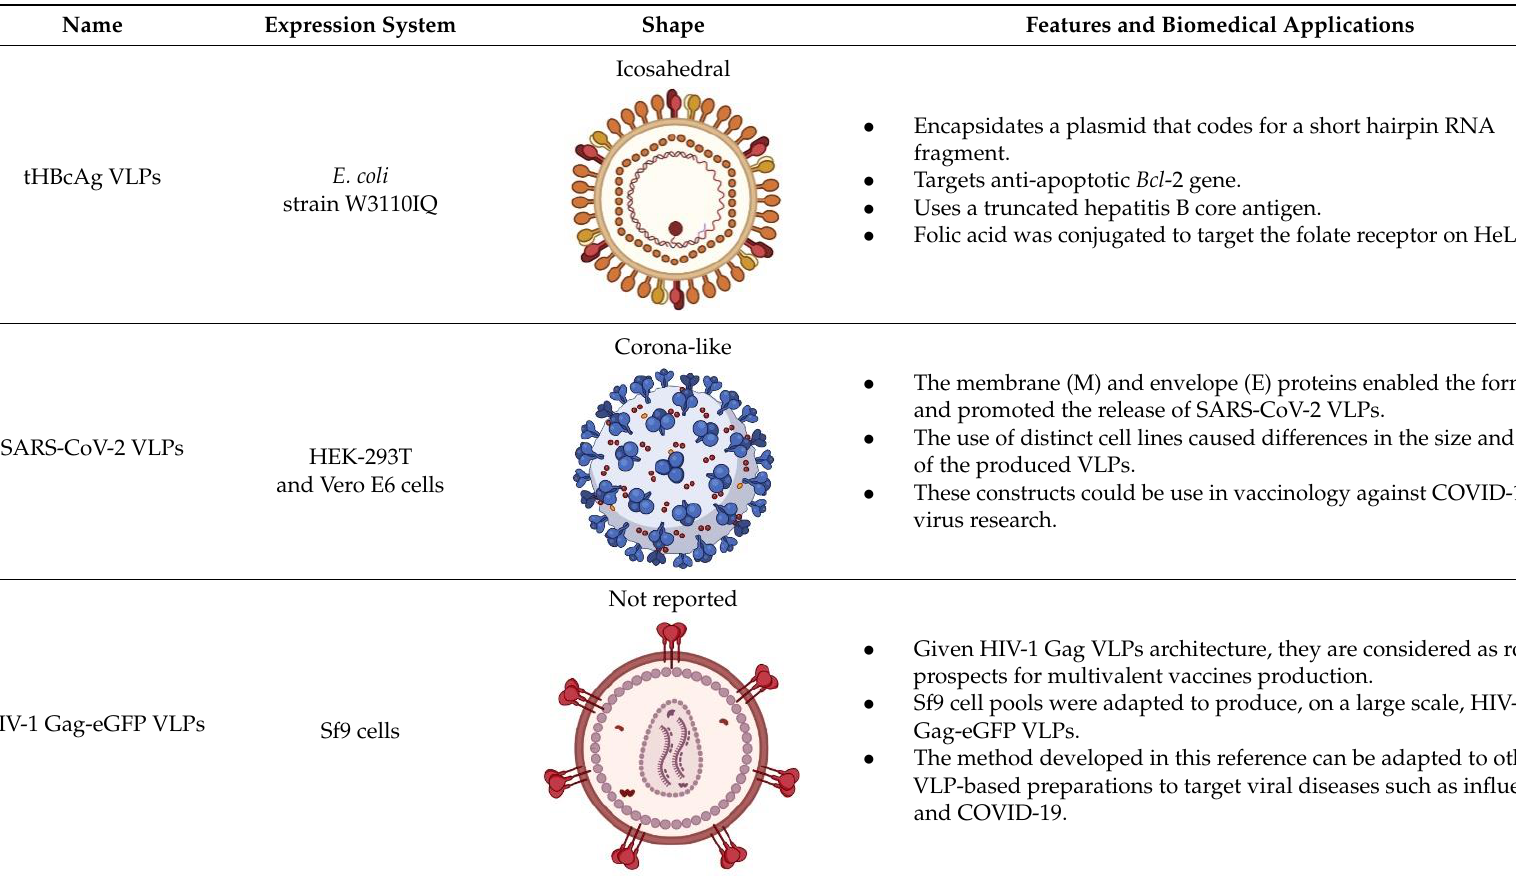
Table 1. VLPs with biomedical applications: expression systems, structure, and features.